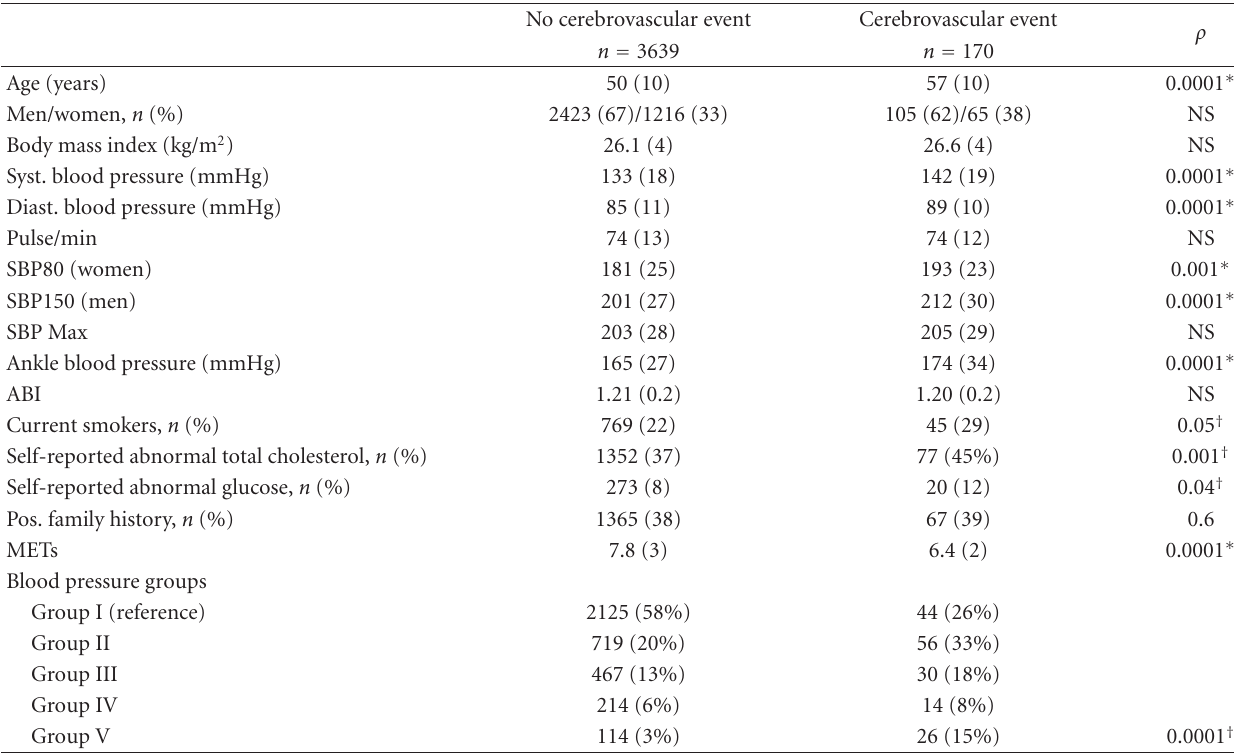
Table 1: Baseline characteristics of participants with and without incident cerebrovascular event during the follow-up.